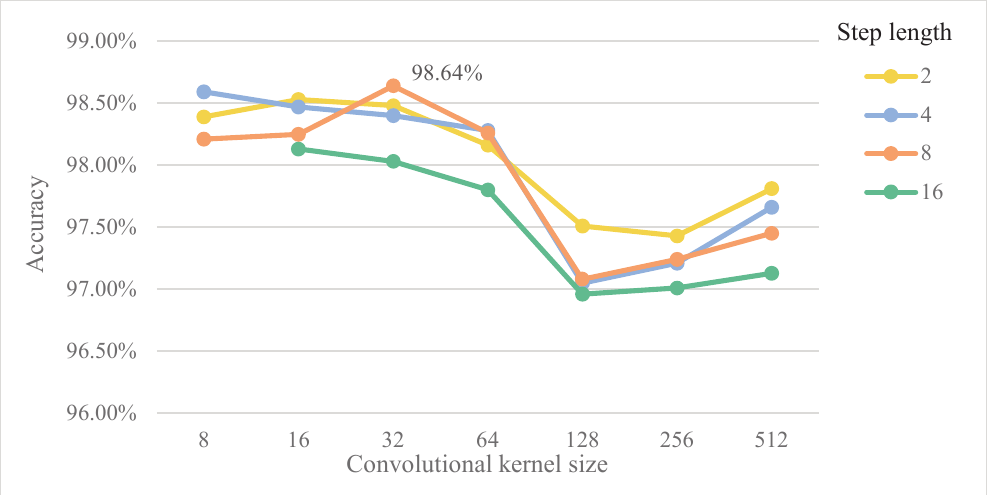
Figure 5. Effects of the convolutional kernel size and step length on the performance of 1D-SCNN.